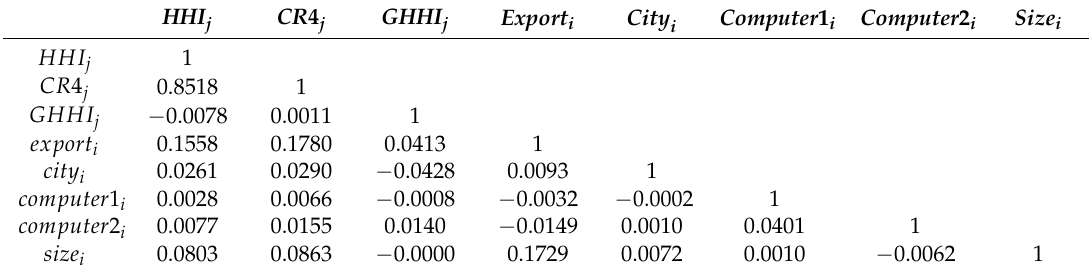
Table 4. Correlation